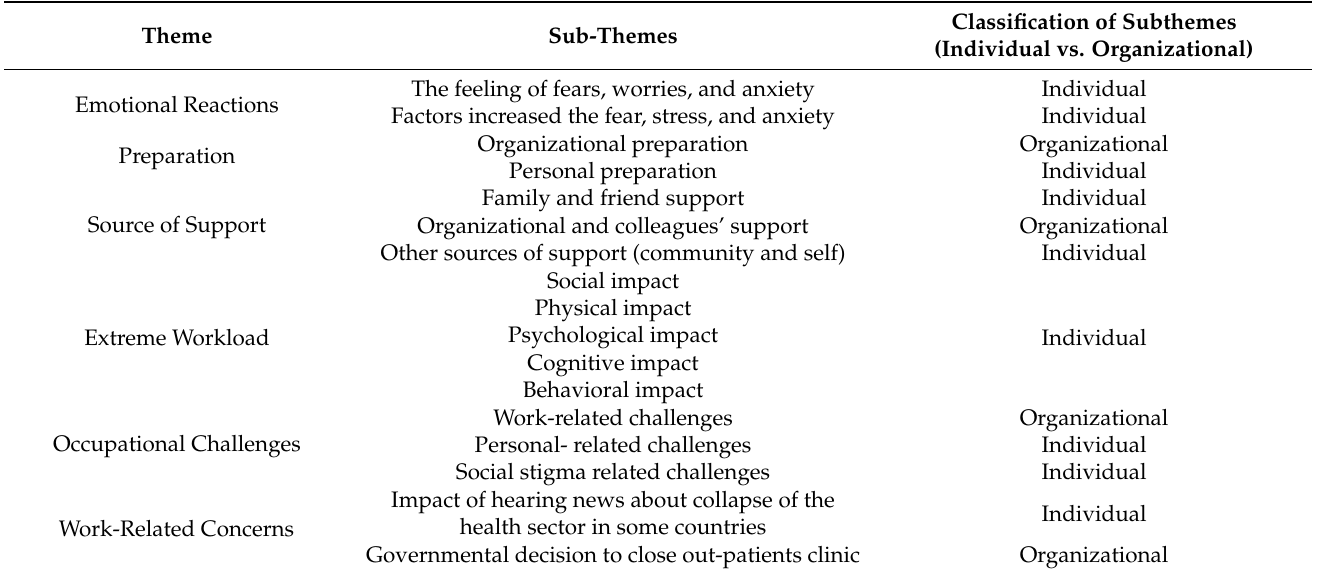
Table 3. Themes and sub-themes of lived experiences of physicians and nurses caring for COVID-19 patients in Jordan.